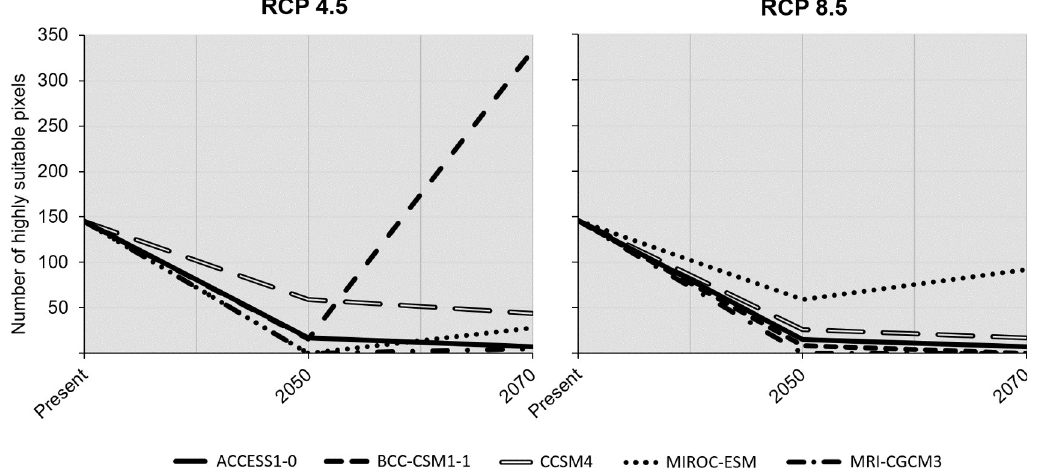
Fig 6. Extension of the most suitable area over time. Number of cells with suitability values above 60% over time (based on Figs 3 and 5), for Representation Concentration Pathways (RCPs) 4.5 and 8.5.